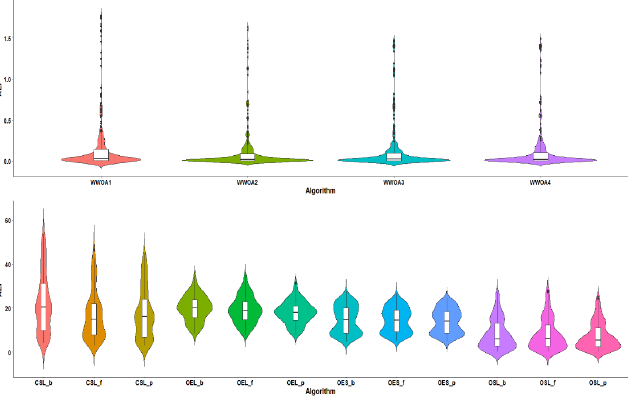
Fig. 3. Violin plots of the AEP distribution for 12 heuristics and 4 WWO algorithms Statistical evidence to verify whether the differences among the 12 heuristics and four WWOA algorithms are important is discussed in the following. First, an analysis of a variance (ANOVA) method and a linear model on AEPs were executed in SAS (version 9.4). However, the normality hypothesis was violated according to the Kolmogorov-Smirnov normality test (with a p-value that is smaller than 0.01, and the value of the D statistic is 0.0706). Therefore, on the significance level of α =0.05, the Freidman test (with p-value <0.0001 and with value of the chi-square statistic equal to 3006.5 and degrees of freedom 15) was executed and affirmed that AEPs are from different distributions based on the AEP ranks obtained on the 288 ( n × τ × R ×weight×(mo×mk)×setup) blocks of test instances. The WNMT (or Wilcoxon–Nemenyi–McDonald–Thompson) was utilized to determine 120 pairwise differences among the 12 heuristics and four WWOAs (see Holland et al ., 2014). Table 5 (Column 2) reveals the obtained results of the AEP’s rank across the 288 blocks for the 12 heuristics and four WWO algorithms. The rank sums of WWOA1 to WWOA4 are 997.0, 661.0, 678.0, and 700.0, respectively. There is no statistically significant difference among the four WWO algorithms at a significance level of 0.05, but the WWOA group is considerably better than any of the 12 heuristics. WWOA2 has the smallest AEP and rank sum for a small number of